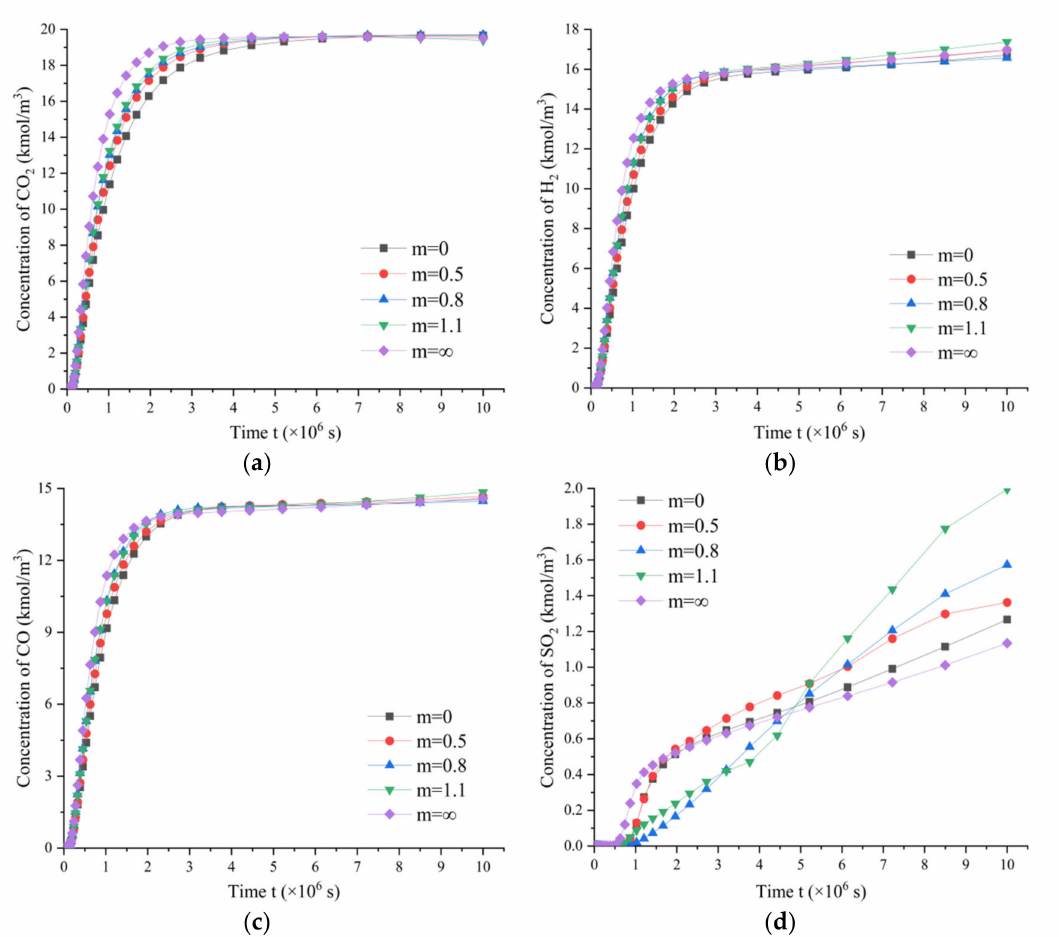
Figure 11. Gas concentration distribution of coal rocks with different densities of fissures. ( a ) concentration of CO 2 ; ( b ) concentration of H 2 ; ( c ) concentration of CO; ( d ) concentration of SO 2